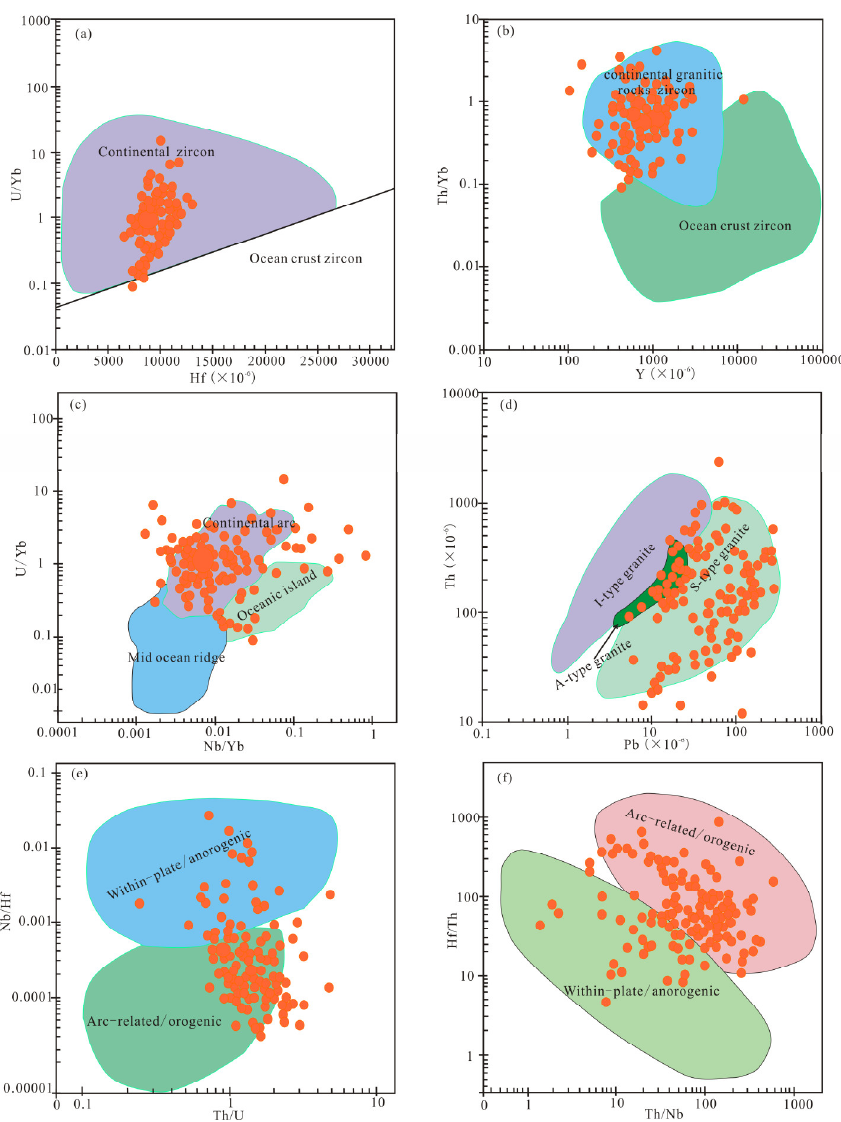
Figure 9. Geochemical discriminant diagrams for detrital zircons from the Jurassic Zhiluo Formation in the Yongshou area. ( a ) Hf–U/Yb diagram (modified after [29]); ( b ) Y–Th/Yb diagram (modified after [82]); ( c ) Th–Pb diagram (modified after [83]); ( d ) U/Yb–Nb/Yb diagram (modified after [29]); ( e ) Nb/Hf–Th/U diagram (modified after [84]); ( f ) Th/Nb–Hf/Th diagram (modified after